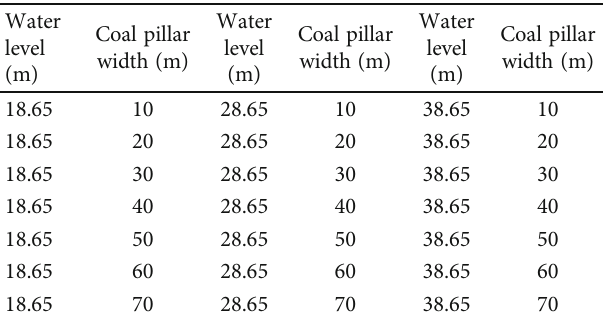
Table 3: Simulation